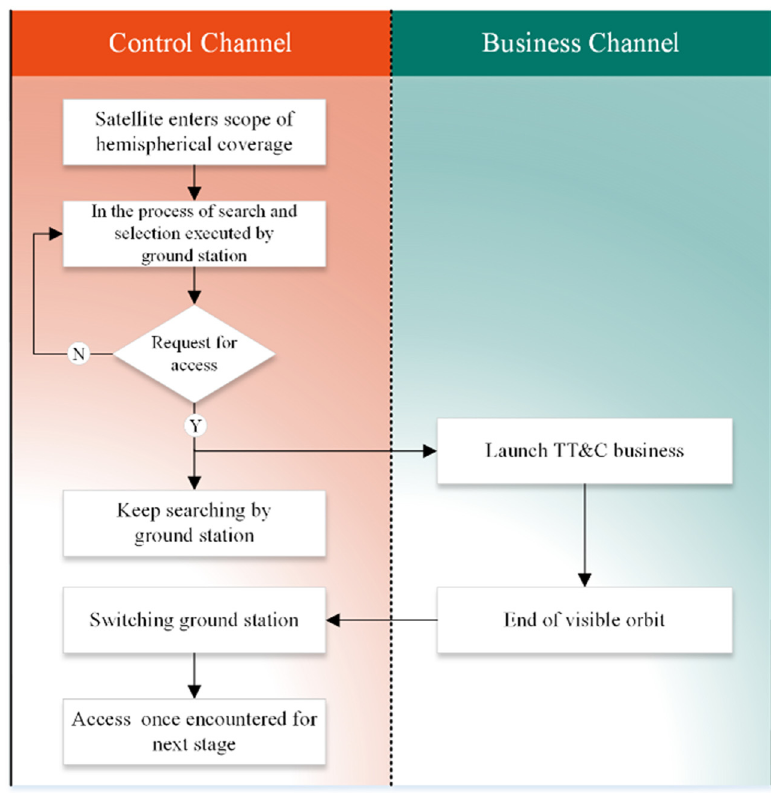
Figure 5: TT&C process based on AOE